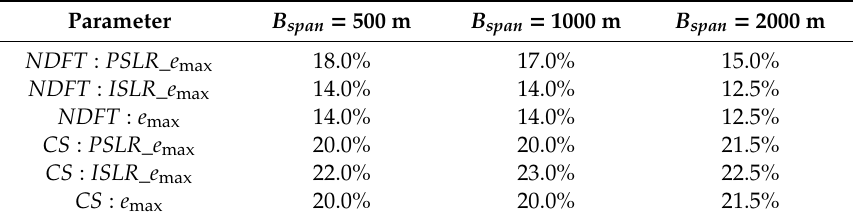
Table 3. The relationship of baseline span and critical deviation about the performance stability.